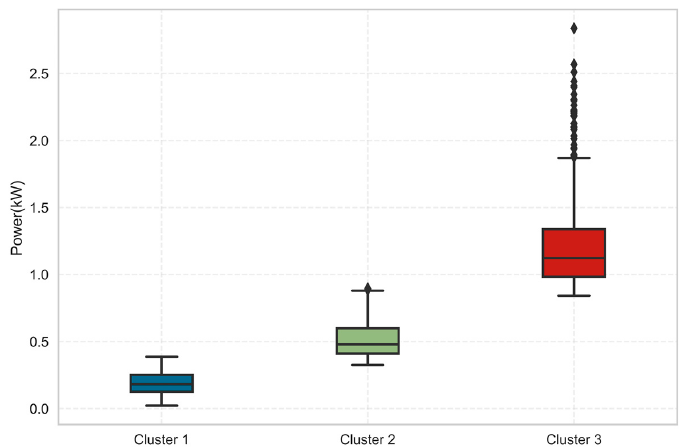
Figure 13. Box and whisker plot of average daily power (kW) usage in three clusters.